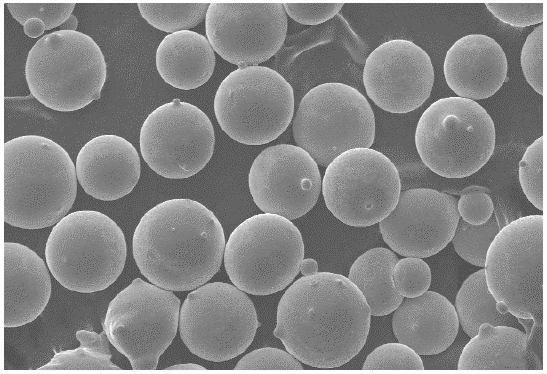
Figure 8. SEM morphology of Co-based alloy powder (220). Table 2. Chemical composition of Co-based alloy powder (mass fraction/%).